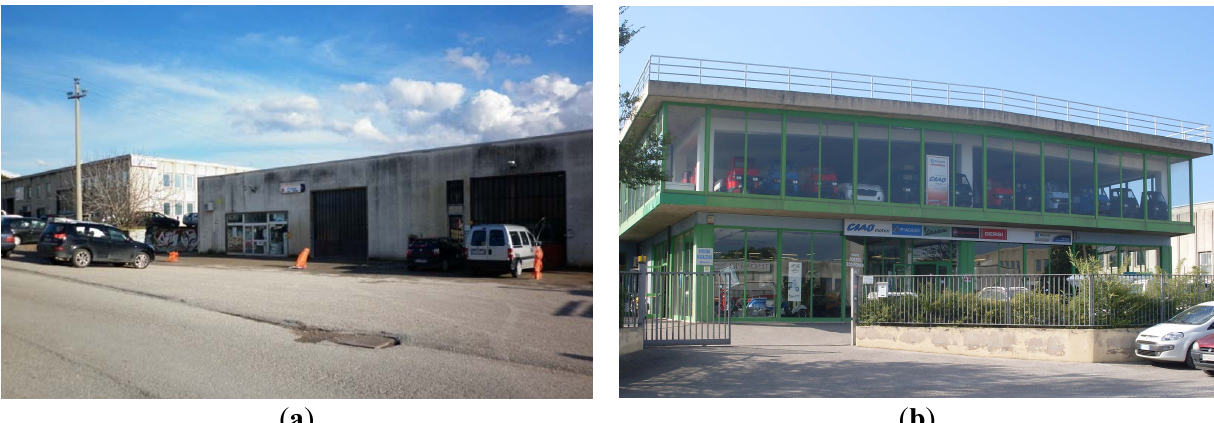
Figure 1. The investigated buildings: building ( a ) No.1 and ( b )